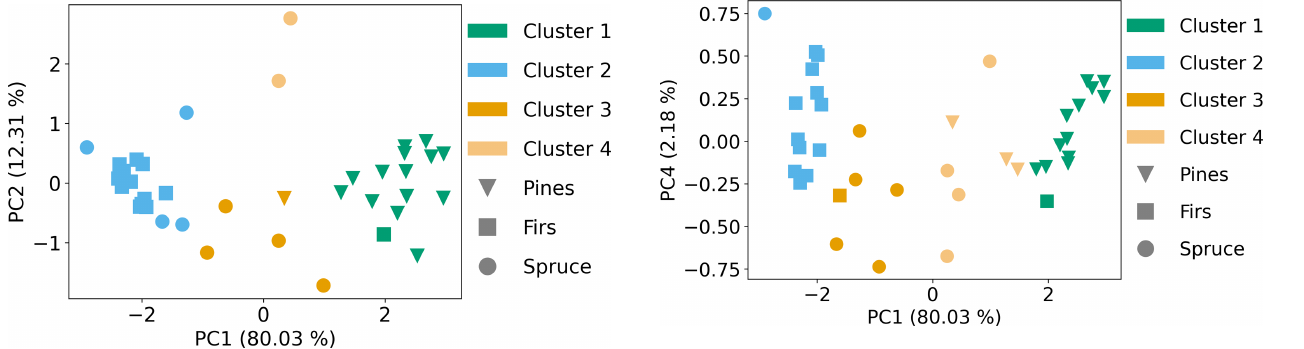
Figure 6. PCA coupled with k -means clustering results for the PC1 and PC2 pair.